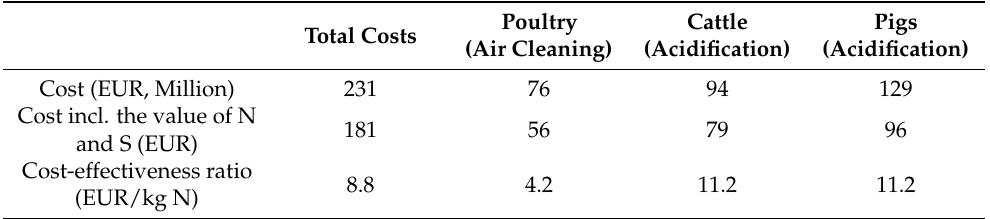
Table 8. The abatement costs for the scenario: total costs and costs distributed across the different animal types. Poultry Cattle Pigs Total Costs (Air Cleaning) (Acidification) (Acidification) Cost (EUR, Million) 231 76 94 129 Cost incl. the value of N 181 56 79 96 and S (EUR) Cost-effectiveness ratio (EUR/kg